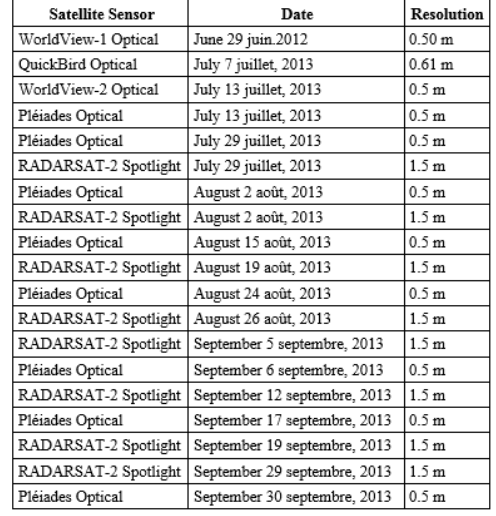
Table 1. Timeline of High-Resolution Satellite Images Acquired The high-resolution (< 1 m in resolution) optical imagery consisted of 11 image dates as listed in Table 1.